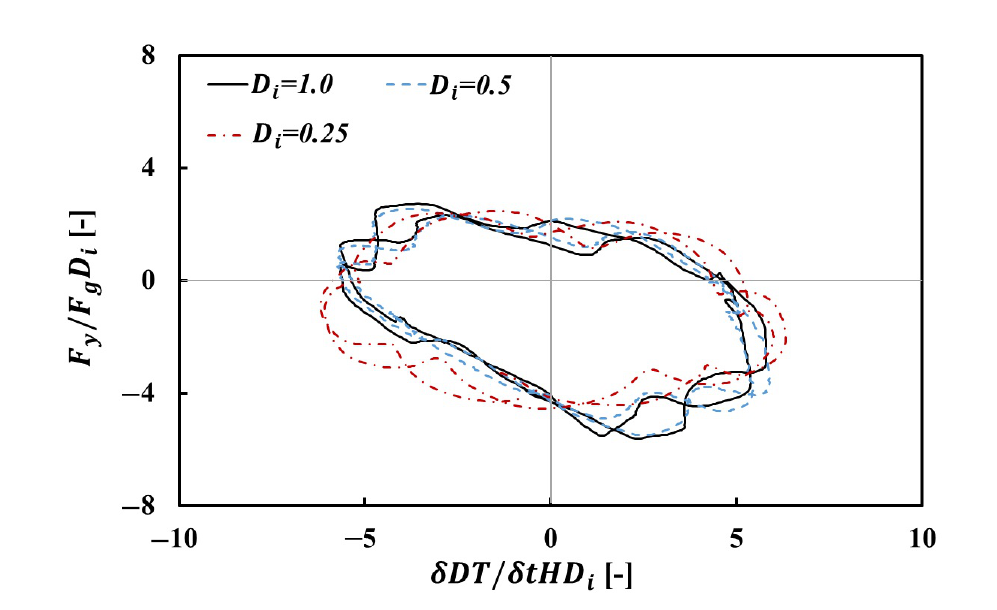
Figure 12. Normalised force–velocity diagram for the eighth and ninth oscillation cycles with N c = 1.